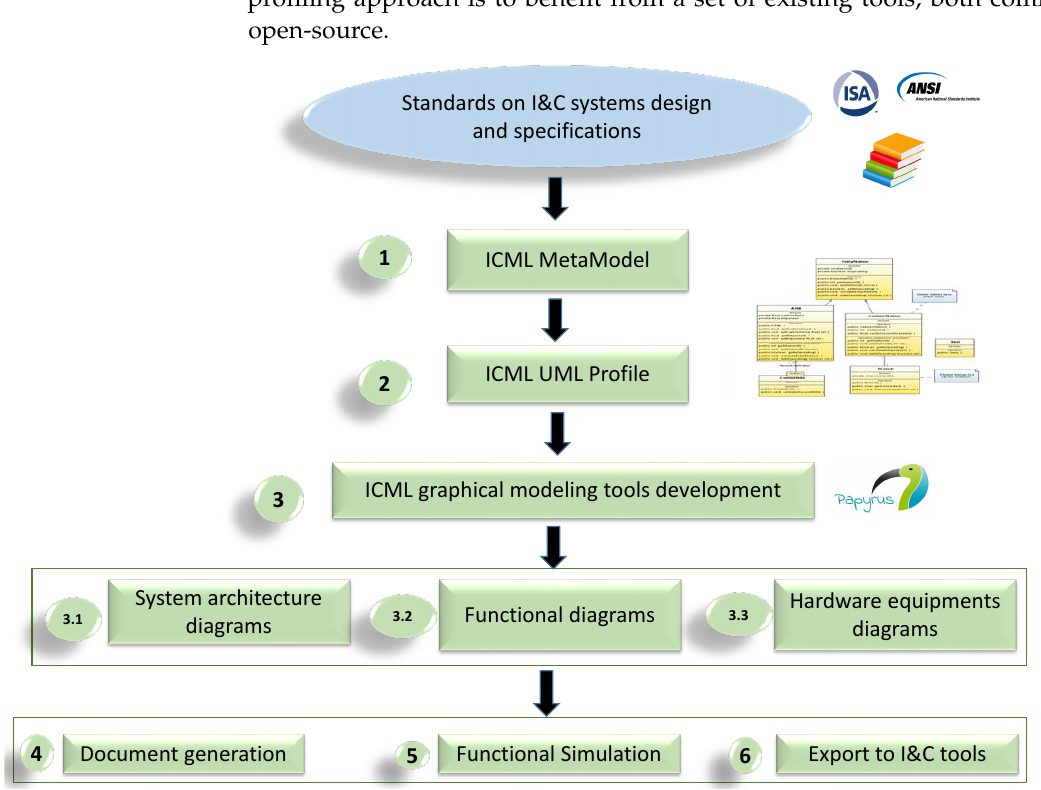
Figure 2. The ICML and associated model-based tools development